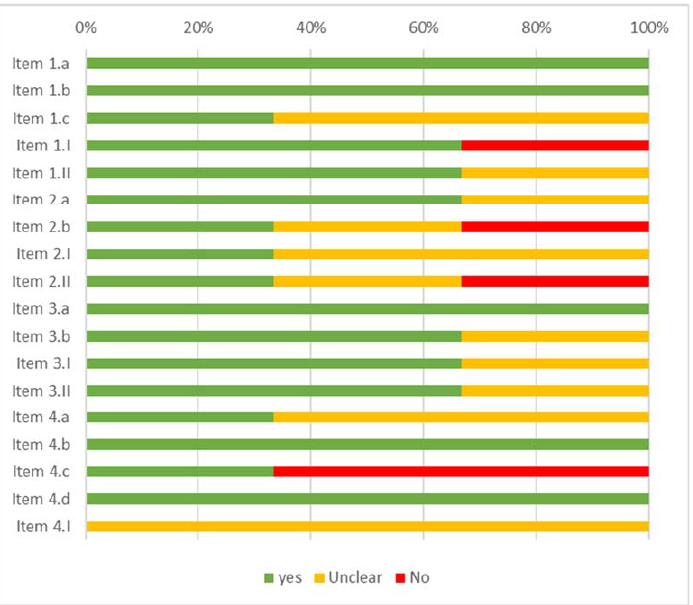
Figure 6. Summary of the critical appraisal process of the cohort studies according to QUADAS 2 [32].